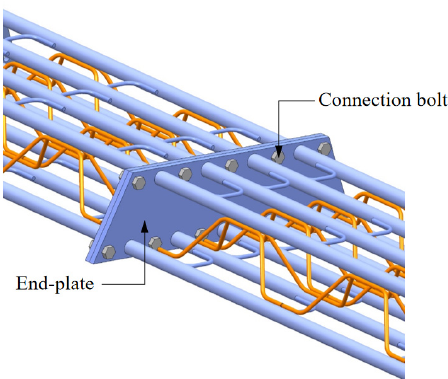
Figure 5. Structural type of the end-plate joint.